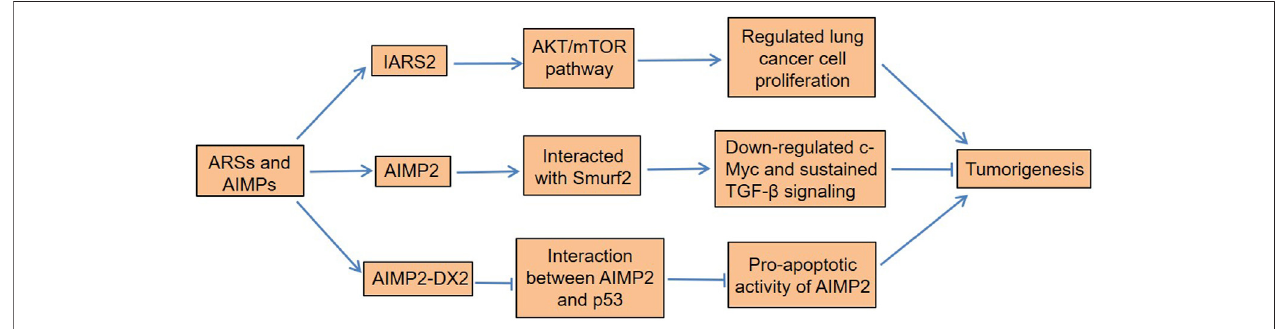
FIGURE2| DysregulationofARSsandAIMPsinlungcancer.IARS2regulateslungcancercellproliferationbyactivating theAKT/mTORpathway.AIMP2interacts with Smurf2 to downregulate c-Myc and sustains TGF- β signaling, thereby inhibiting tumorigenesis. Moreover, AIMP2-DX2 reduces the proapoptotic activity of AIMP2 by competitive binding to p53, which induces lung tumorigenesis. ARSs, aminoacyl-tRNA synthetases; AIMPs, ARS-interacting multifunctional proteins; IARS2, isoleucyl-tRNA synthetase 2; Smurf2, Smad ubiquitination regulatory factors 2; TGF- β , transforming growth factor- β ; AIMP2-DX2, AIMP2 lacking exon